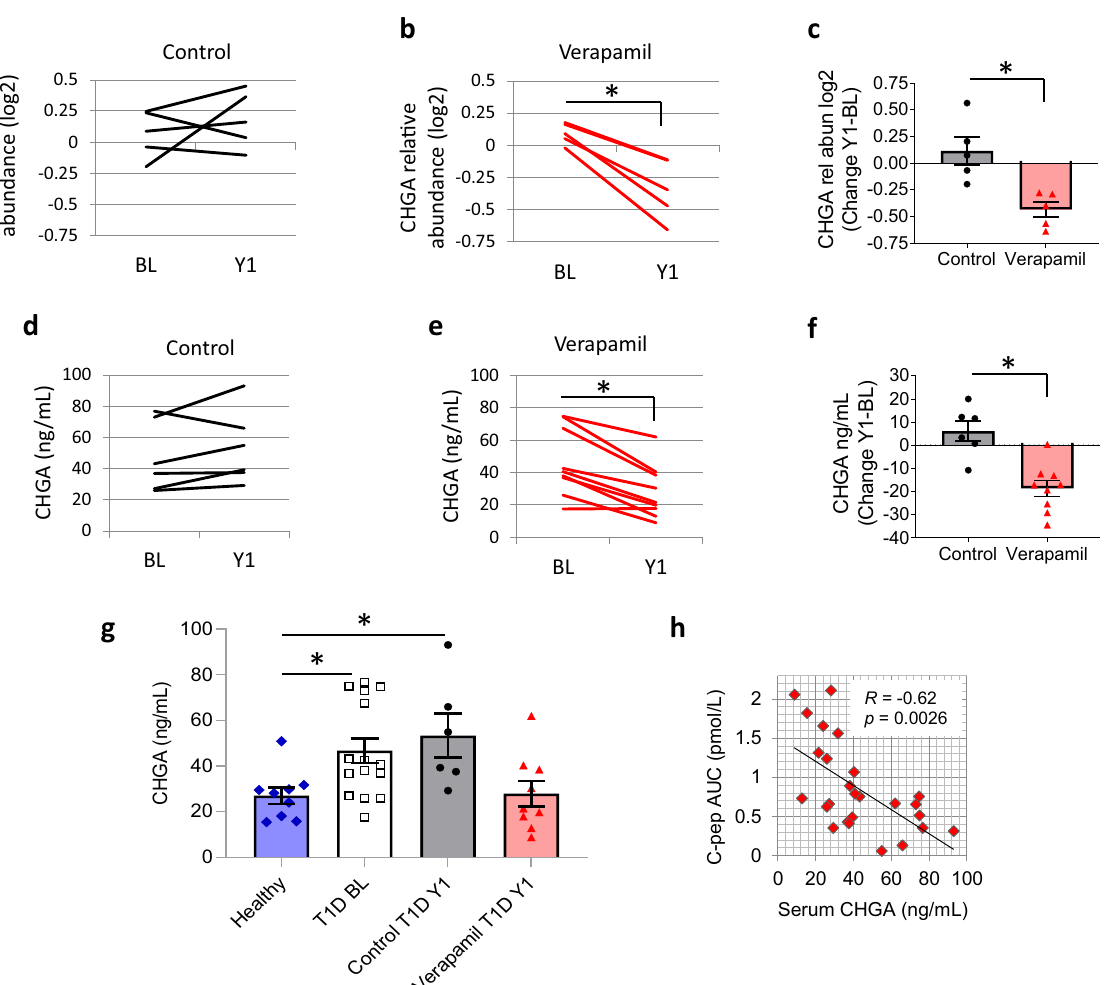
Fig. 1 Serum CHGA in response to verapamil treatment of subjects with T1D. CHGA as assessed by LC-MS/MS ( y -axis represents relative abundance levels in zero-centered log2 form) in serum at baseline (BL) or at 1 year (Y1) of individual control subjects with T1D receiving placebo (black) ( n = 5) (NS) ( a ) or verapamil (red) ( n = 5) ( t 4 = 5.966, *P = 0.0040) ( b ). Comparison of the changes in CHGA (BL to Y1) as assessed by LC-MS/MS in the verapamil and the placebo group ( t 8 = 3.674, *P = 0.0063) ( c ). Serum CHGA levels at BL or Y1 as assessed by ELISA in individual control subjects with T1D receiving placebo ( n = 6) (NS) ( d ) or verapamil ( n = 9) ( t 8 = 5.44, *P = 0.0006) ( e ). Comparison of the changes in CHGA (BL to Y1) as assessed by ELISA in the verapamil and the placebo group ( t 13 = 4.497, *P = 0.0006) ( f ). Serum CHGA levels in healthy, non-diabetic volunteers (blue) ( n = 9) as assessed by ELISA and compared to subjects with T1D at baseline (T1D BL) (white) ( n = 15), subjects with T1D getting placebo for 1 year (Control T1D Y1) ( n = 6) or receiving verapamil for 1 year (Verapamil T1D Y1) ( n = 9) ( F 3,35 = 4.392, * P = 0.01) ( g ). Correlation of C-pep AUC and serum CHGA ( R = − 0.62, P = 0.0026) ( h ). Bars represent means ± SEM. For a , b , d , e , two-tailed, paired Student ’ s t -test. For c , f , two-tailed Student ’ s t -test. For g , one way ANOVA and for h , repeated measures correlation coef fi cient by mixed model. Subject characteristics are listed in Supplementary Table 1. Source data are provided as a Source Data fi